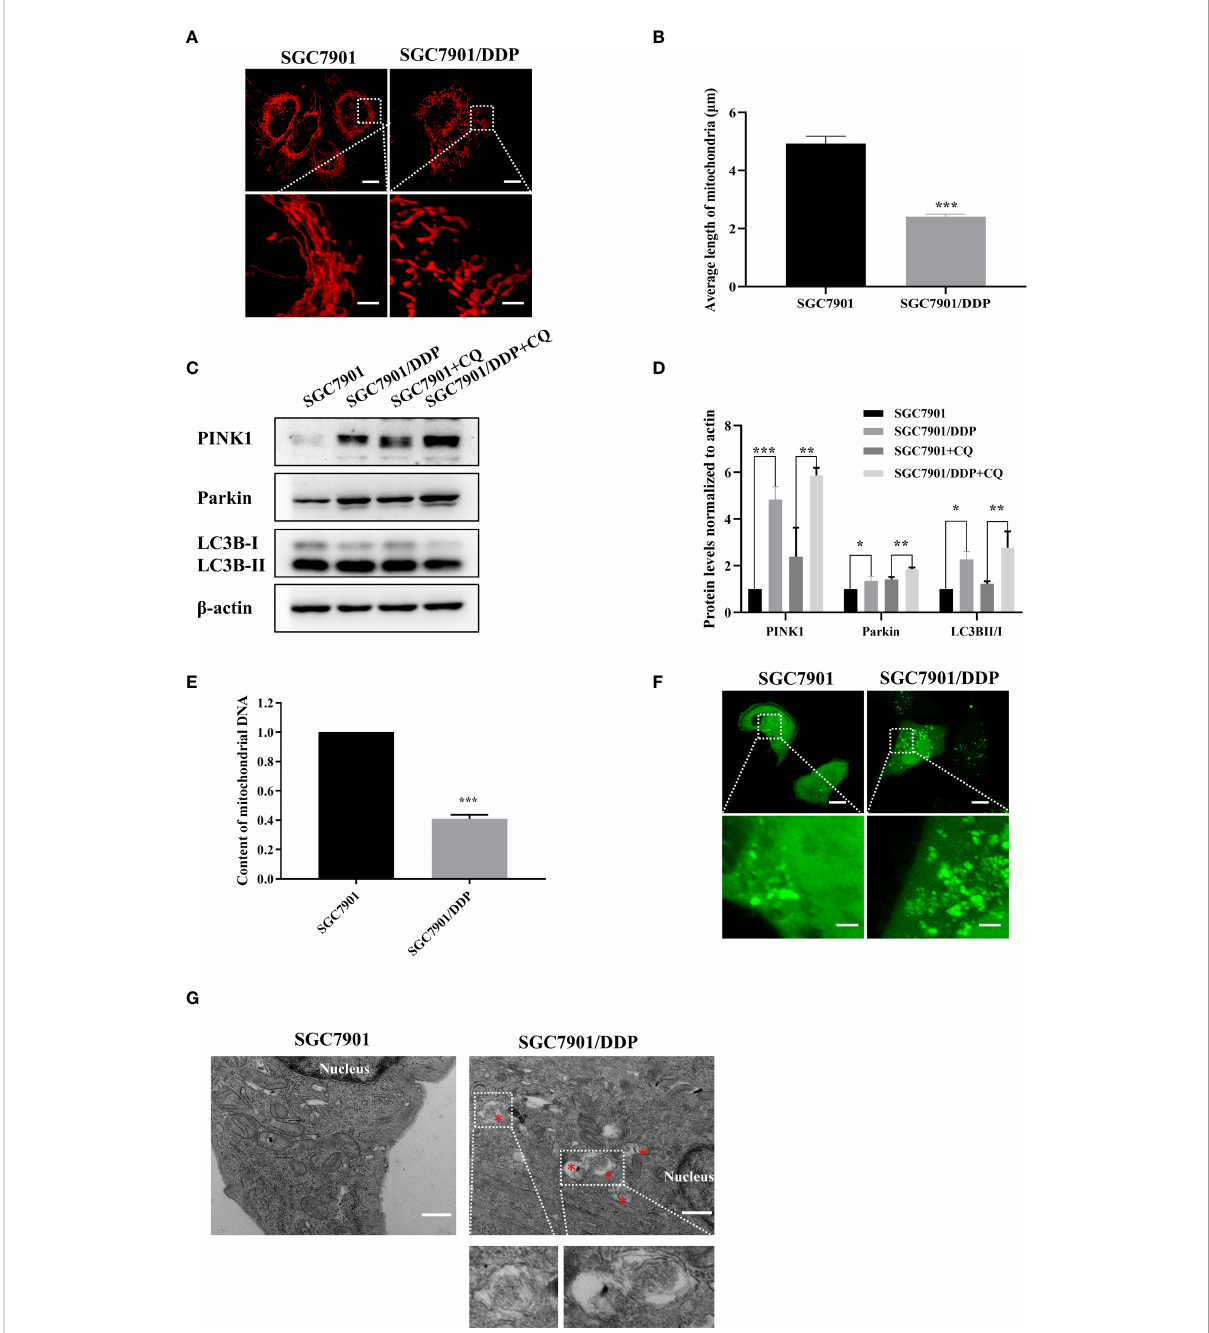
FIGURE 1 Mitochondrial fi ssion and mitophagy were increased in the cisplatin resistant SGC-7901/DDP cells. (A, B) Mitochondrial morphology in SGC- 7901 and SGC-7901/DDP cells. Cells were transfected with pDsRed2-Mito. Scale bar of top fi gures is 10 m m. Scale bar of bottom fi gures is 2 m m. Mitochondria length in each group was measured. (C, D) Expression of PINK1, Parkin and LC3B in SGC-7901 and SGC-7901/DDP cells. SGC-7901 and SGC-7901/DDP cells were treated with or without 10 µM CQ for 24 h. Whole cell lysates were collected for western blot assay. (E) Changes of mitochondrial DNA content. Total DNA were isolated from SGC-7901 and SGC-7901/DDP cells and the amount of mitochondrial DNA was determined by real-time PCR. (F) SGC7901 and SGC7901/DDP cells were transfected with pEGFP-LC3B for 24 h and then analyzed by confocal microscope. Scale bar=10 µm. Circled images at higher magni fi cation are shown in the below panels. Scale bar= 2 µm. (G) SGC7901 and SGC7901/DDP cells were processed by transmission EM. Asterisk represents mitophagy vesicles. Circled images at higher magni fi cation are shown in the below panels. Scale bar=0.5 µm. Data were presented as the means ± SD. The experiments were repeated three times independently. ** p <0.01, *** p